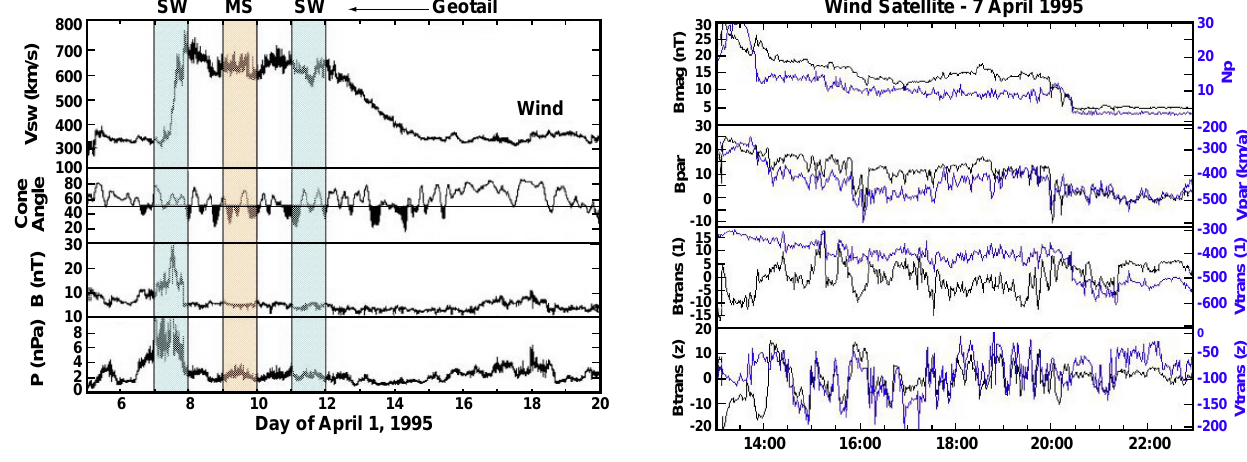
when both are in the solar wind on the dusk side, with Wind ∼ 200 R E upstream and Geotail just in front of the bow shock. Then we compare Wind and Geotail data, when both are on the dawn side (13:00–20:00 UT, 19 June 1995), Wind is still ∼ 200 R E upstream but Geotail is in the magne- tosheath. We have no intervals when Geotail is in the dawn magnetosheath with KIL also on the dawn side. We show instead a comparison of Wind and KIL data when both are on the dawn side (02:00–10:00 UT 19 June 1995). Our first interval corresponds to the first sub-interval in Fig. 4, when both Wind and Geotail are in the solar wind on the dusk side. We show perturbations in magnetic field and velocity in field-aligned coordinates during the compression region on 7 April 1995: one parallel and two transverse com- ponents in the bottom three panels of Fig. 5. In the top panel we show magnetic field magnitude and ion density. Both of these are high at the beginning of the plot, decrease just before 14:00 UT and again at about 20:30 UT. Because the magnetic field magnitude and the density are changing sig- nificantly up until 20:30 UT, we expect the fluctuations not to be Alfv´enic in this region. Aperiodic Alfv´en waves would show a correlated variation between the components, as de- fined by the relation, b = ± ( 4 πρ) 1 / 2 v (Belcher and Davis, 1971). This is not the case, as can be seen in the bottom 3 panels of Fig. 5. After the drop in magnetic field magnitude and ion density at about 20:30 UT the values remain fairly steady for the remainder of the